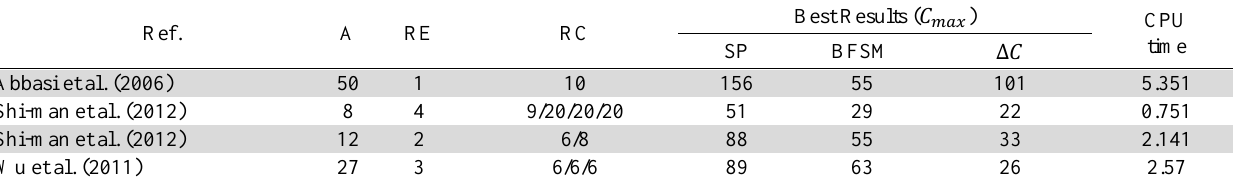
Results of Computational Experience